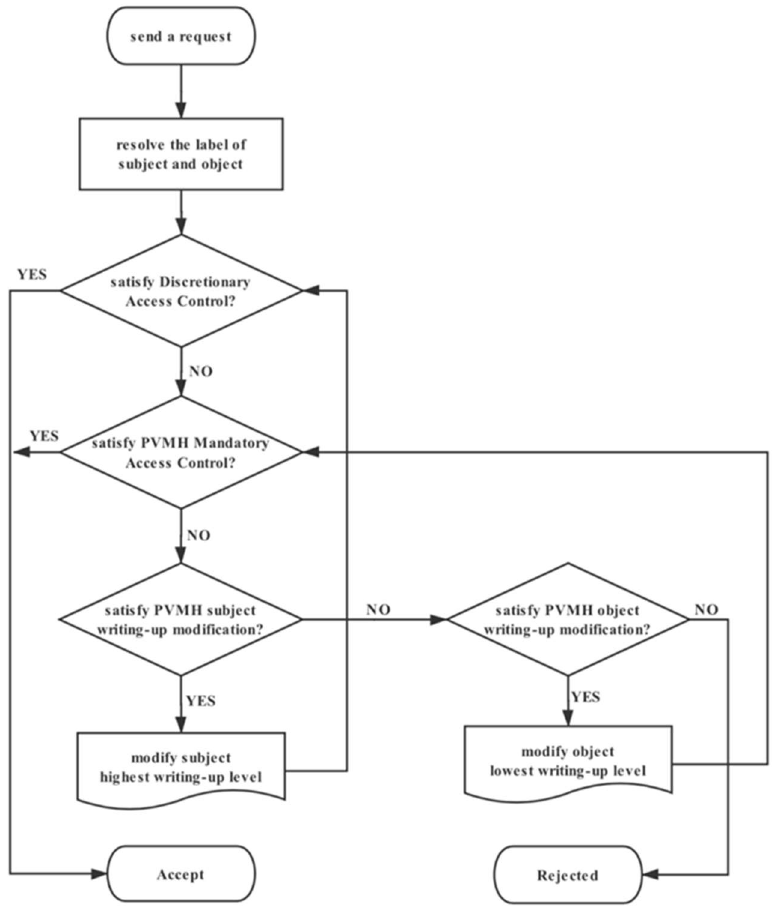
Figure 2. Access flowchart. high-res figure